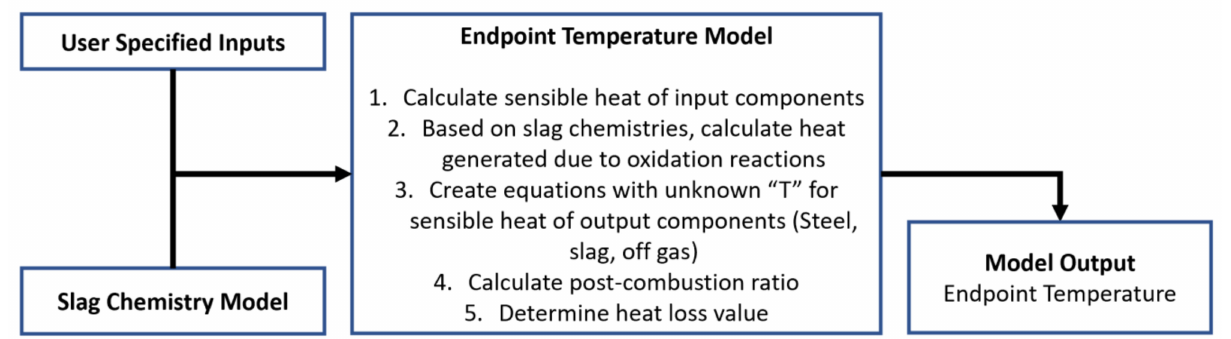
Figure 4. Flowchart of the endpoint temperature theoretical